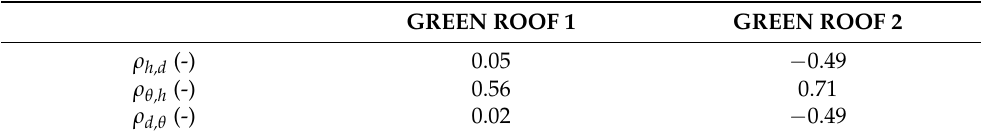
Table 8. Correlation indexes among rainfall variables in